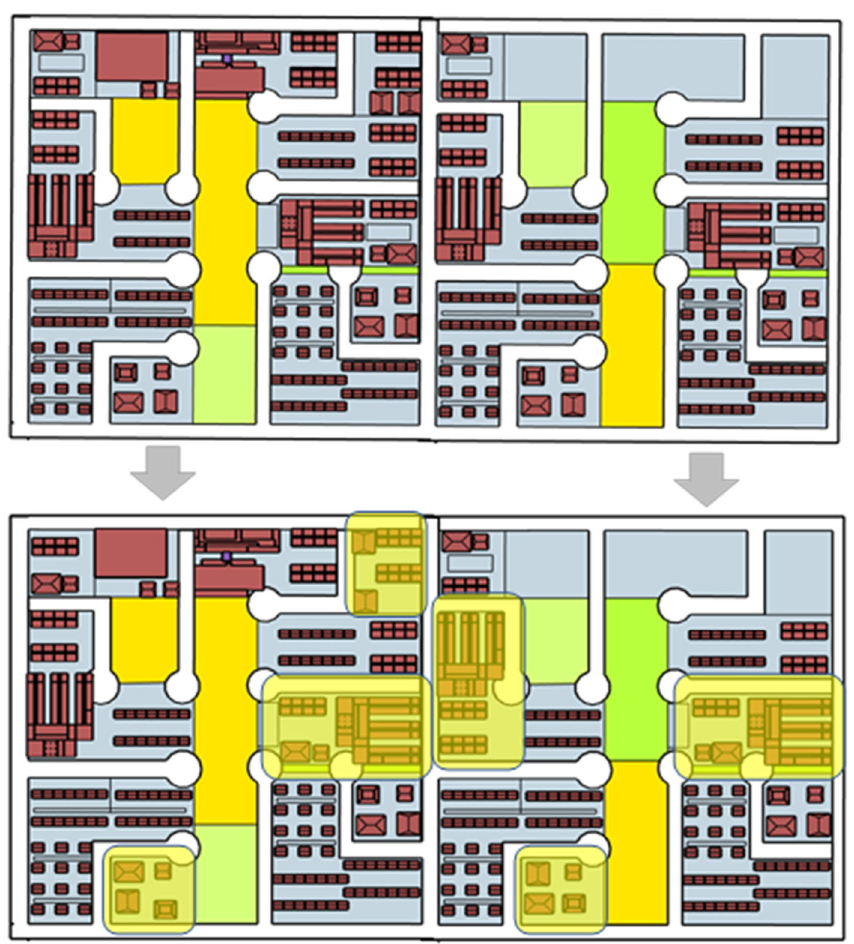
Figure 6. Updated layout of C1 based on observations during resilience analysis (movement of buildings highlighted in yellow blocks).